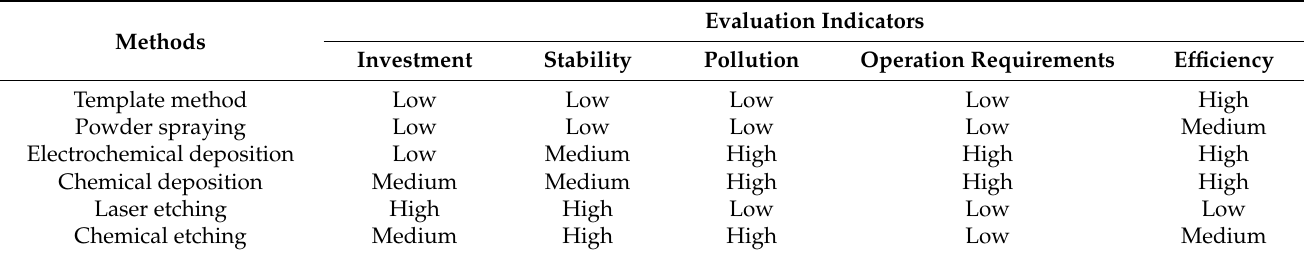
Table 3. Relative comparisons of different methods for fabricating superhydrophobic